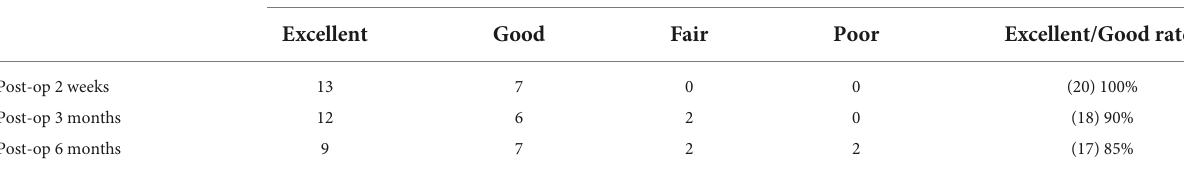
TABLE 2 Modified MacNab criteria at postoperative different follow-up